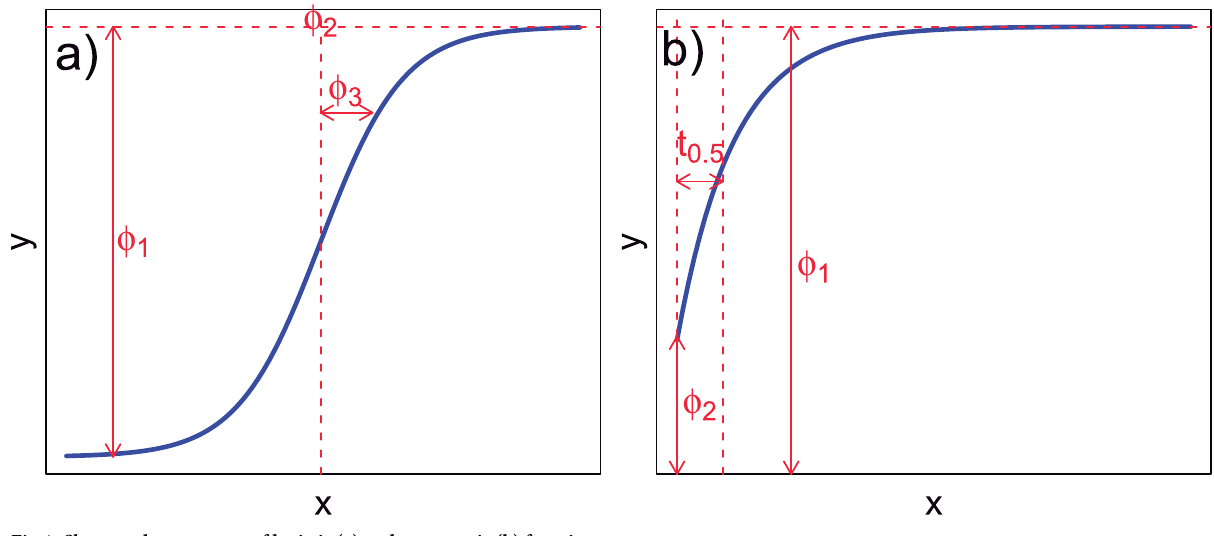
Fig 4. Shape and parameters of logistic (a) and asymptotic (b)